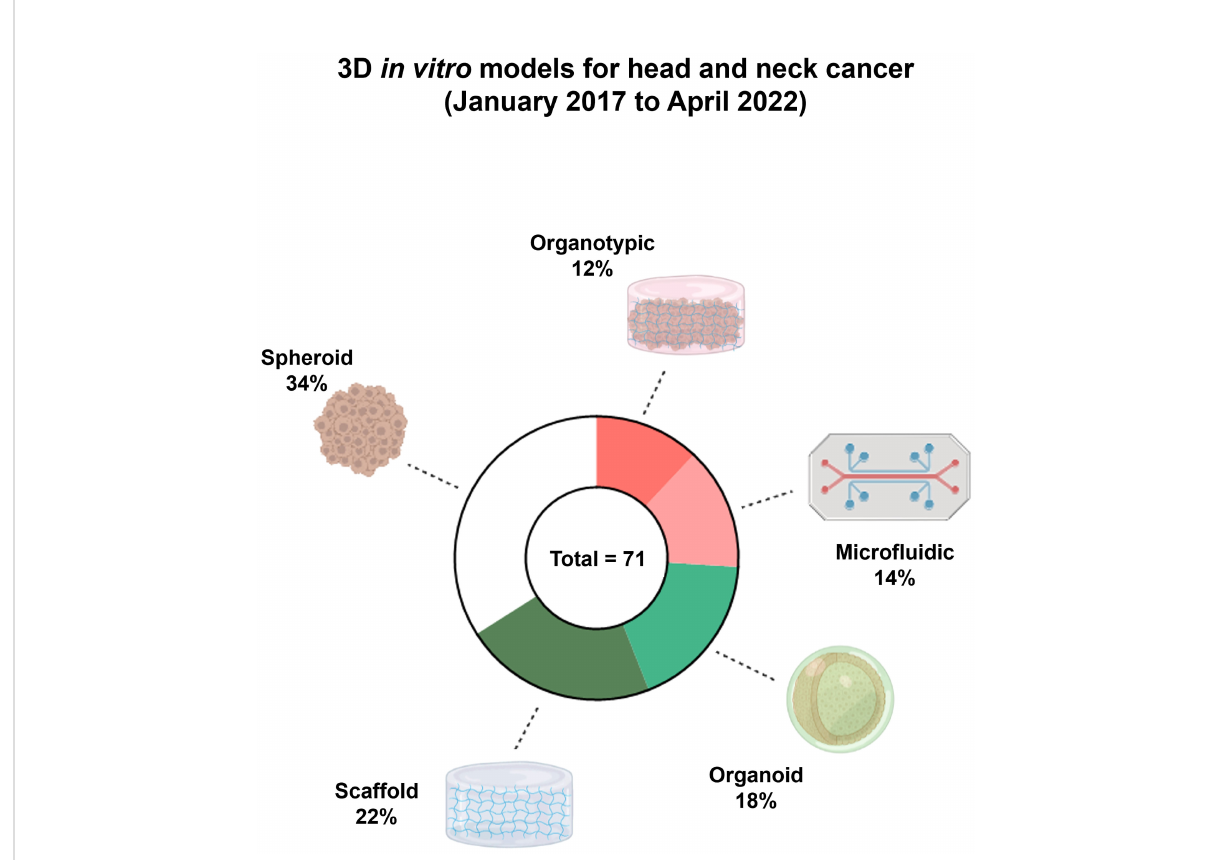
FIGURE 1 Culturing models in head and neck (H&N) cancers. Pie graph of published articles between 2017 and 2022 using the NCBI PubMed ® . Related publications of three-dimensional (3D) in vitro models in H&N cancer with spheroids being the most abundant type of culture model. Figure created with BioRender.com and GraphPad Prism